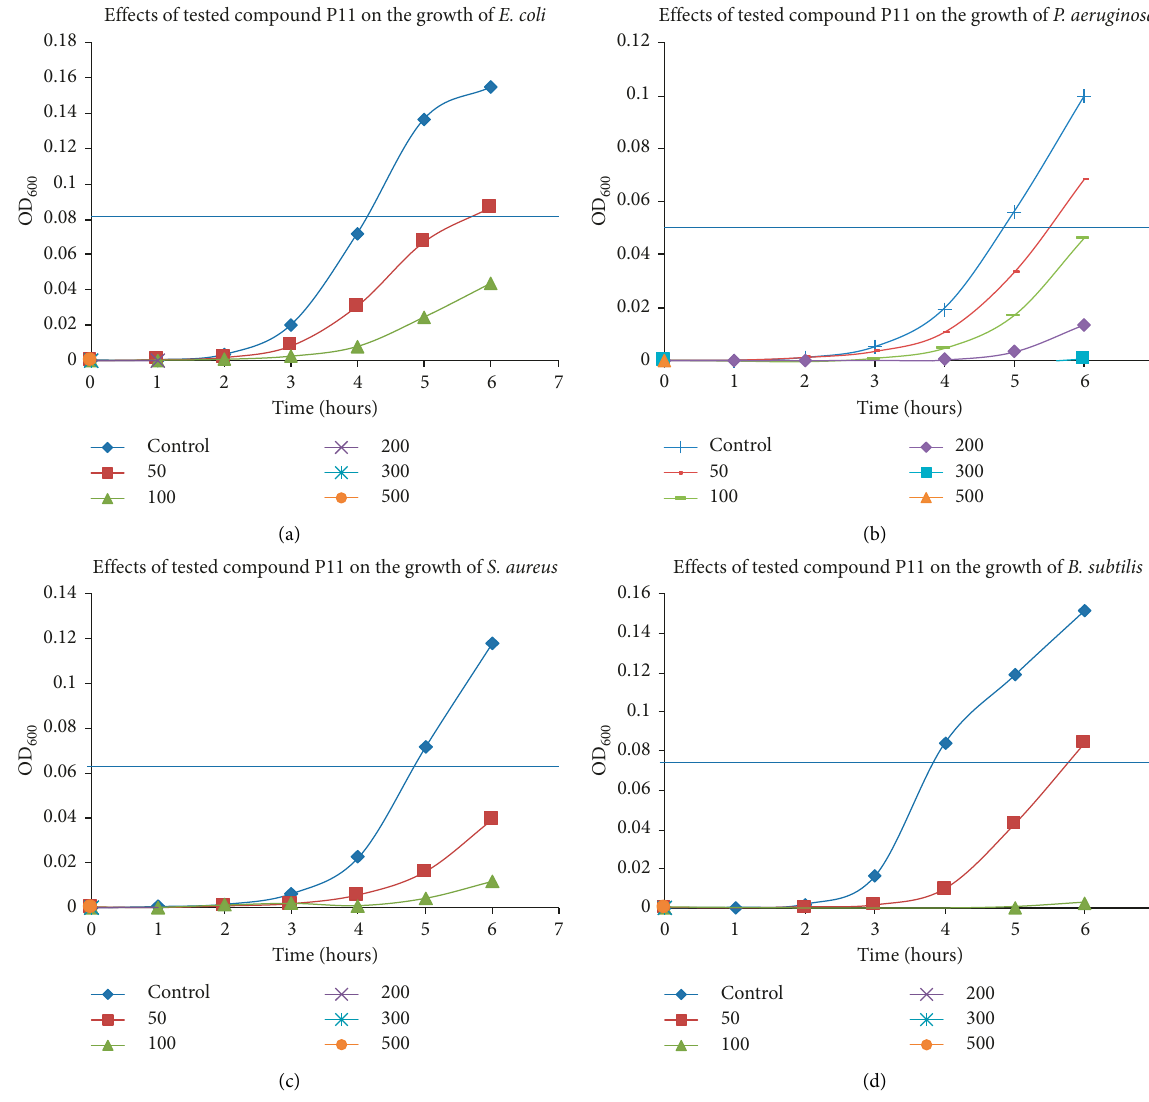
Figure 3: Effects of different concentrations of compound P11 against different time points. All compound concentrations are in µ